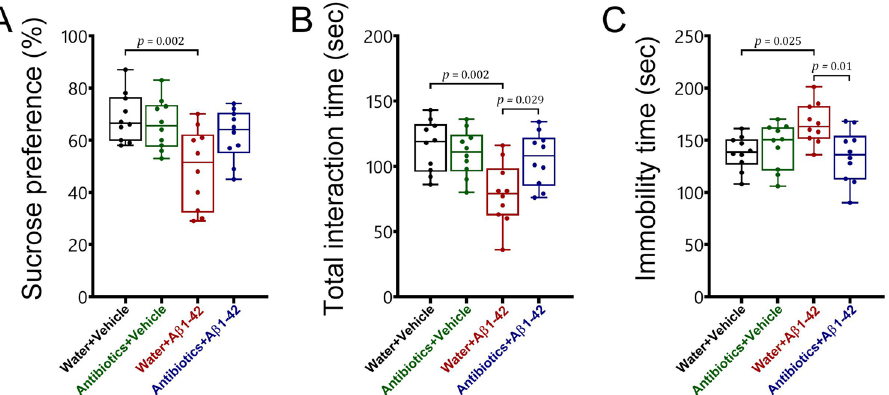
Figure 6. The effects of antibiotic treatment alone or in combination with Aβ1–42 treatment on depression- related behaviours in male C57BL6 mice. To assess depression-related behaviour, animals were subjected to sucrose preference ( A ), social interaction ( B ; total interaction time) and forced swim ( C ; immobility time) tests. Data are expressed as mean ± SEM (n = 10). Antibiotic treatment did not change [ p > 0.05] the percentage of sucrose preference, total interaction time, and immobility time in mice relative to the water + vehicle group. We also found that Aβ 1–42 administration significantly decreased the percentage of sucrose preference [ p = 0.002] and the total interaction time [ p = 0.002] but increased the immobility time [ p = 0.025] in water-treated mice as compared to the water + vehicle animals. In addition, there were significant differences in the total interaction time [ p = 0.029] and the immobility time [ p = 0.01] between water + Aβ 1–42 and antibiotics + Aβ 1–42 groups. However, antibiotic treatment could not affect the sucrose preference [ p > 0.05] in antibiotic-treated mice as compared to both the antibiotics + vehicle and water + vehicle groups. We also did not find any significant differences [ p > 0.05] in sucrose preference, the total interaction time and the immobility time between antibiotics mice treated with Aβ 1–42 and the antibiotics + vehicle- or water + vehicle-treated animals.